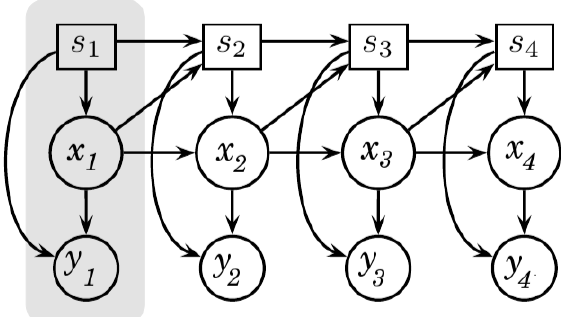
Figure 5. Bayesian Network representation of the Augmented Switching Linear Dynamical System. A slice is highlighted in